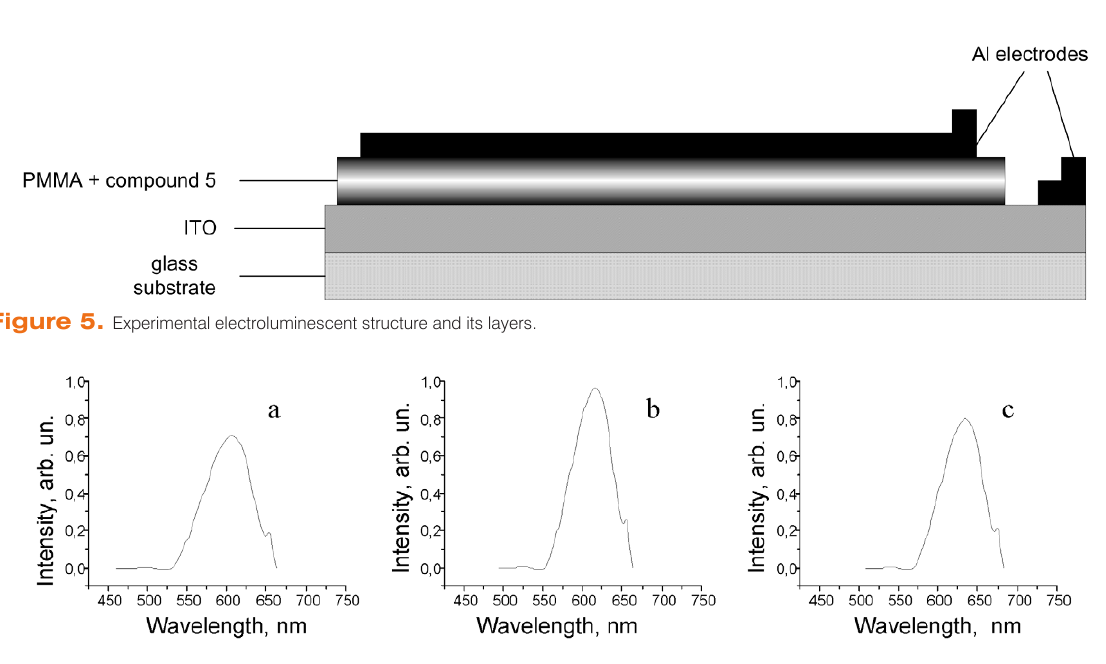
Figure 6. Electroluminescent spectra of EL structure with compound 5 incorporated in light emitting layer at three different AC frequencies: a) at 1 KHz; b) at 1.5-2 KHz; c) at 3 KHz. Table 1. Absorbance and fluorescence maxima and fluorescence quantum yields of compounds 5 and 10 in CHCl